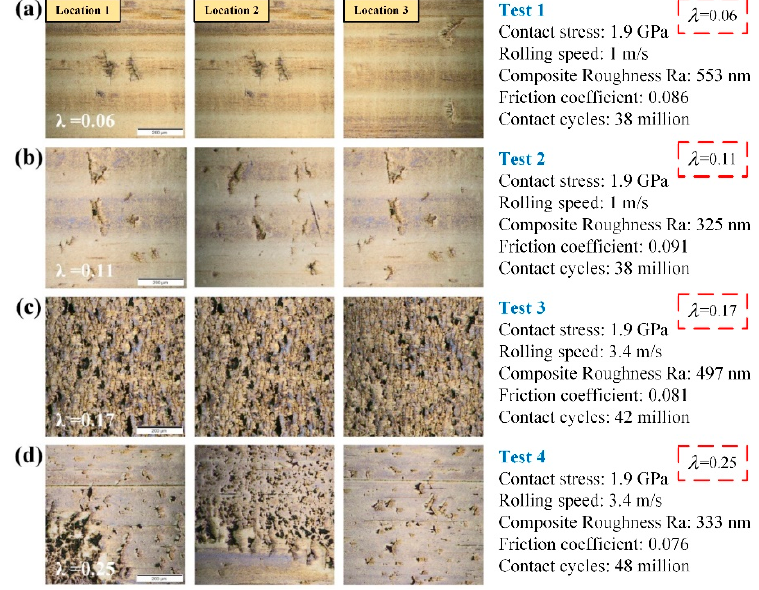
Figure 16. The roller surface and operating parameters of tests 1–4 ( a – d ) [121].